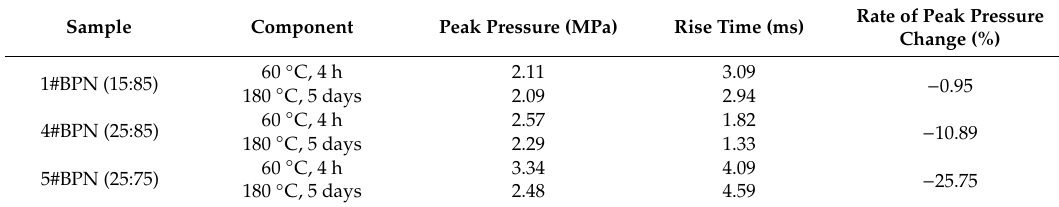
Table 8. P-t curve of BPN samples in 180 ◦ C test